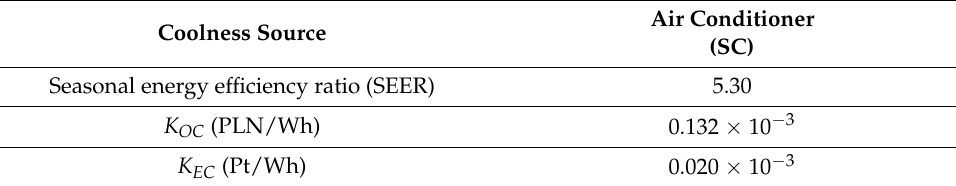
Table 4. Data for cooling.